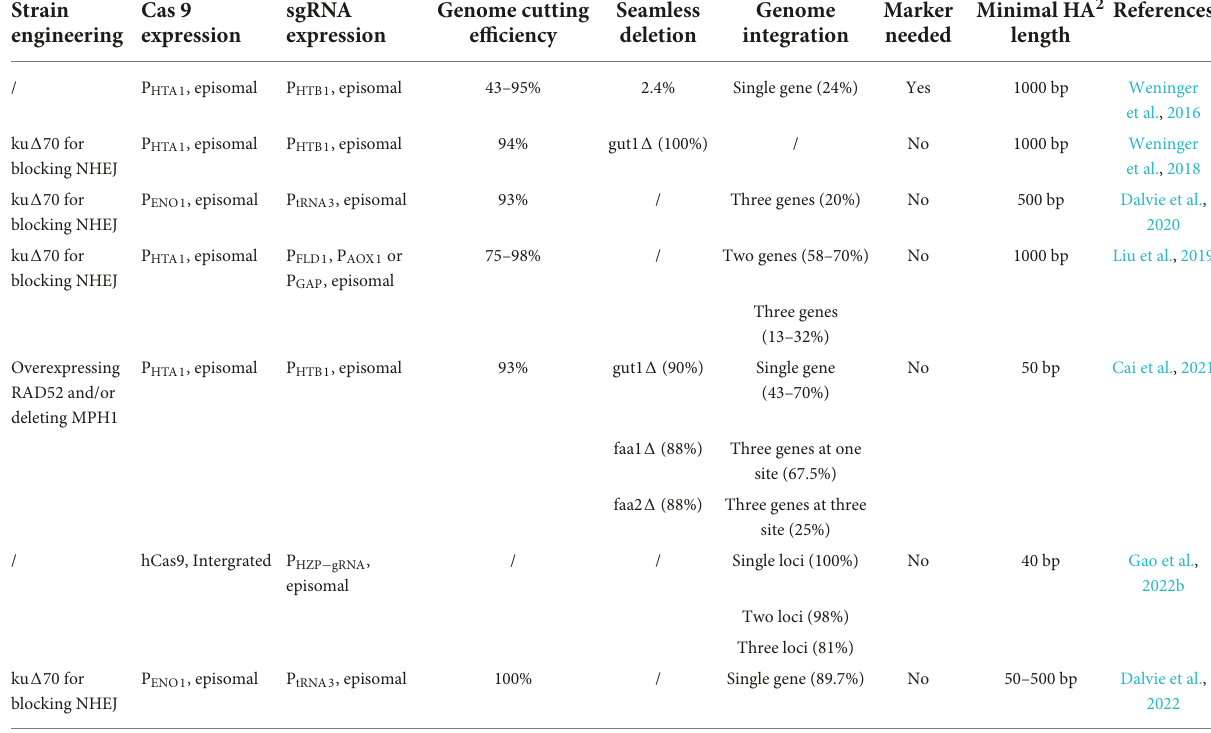
TABLE 1 Genetic engineering tools for Pichia pastoris through HR, 1 adapted from Cai et al.